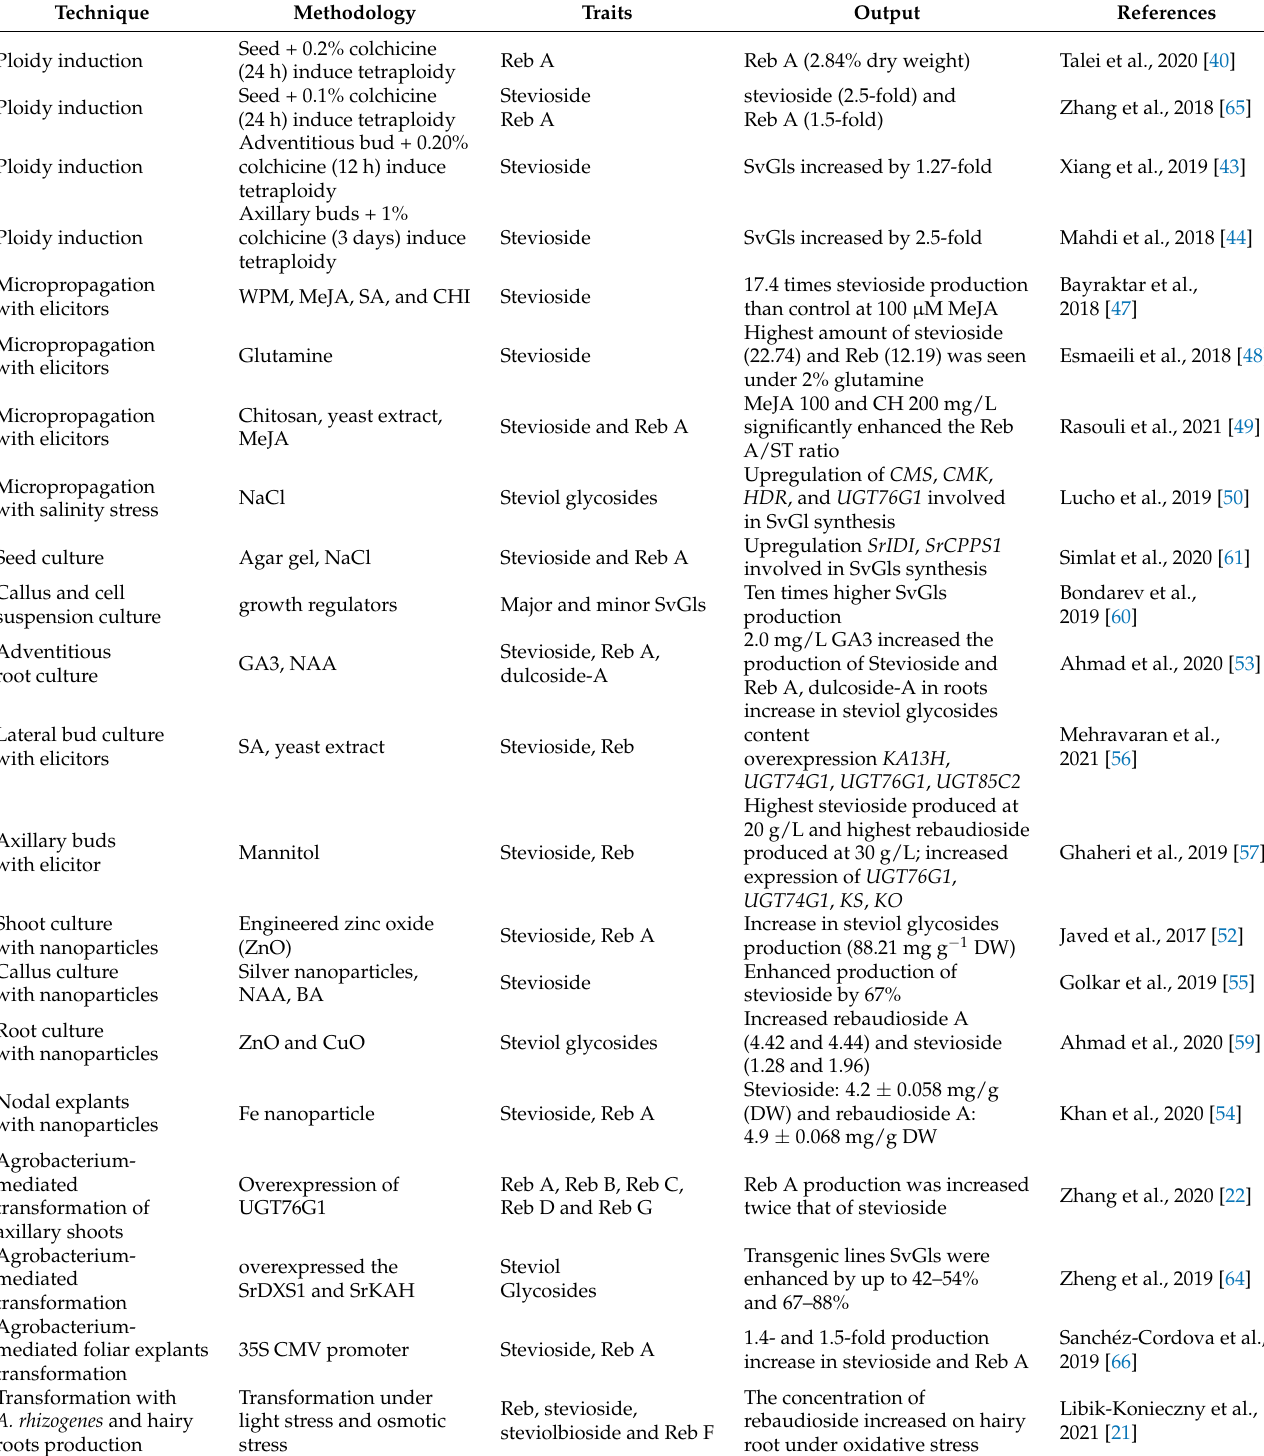
Table 2. Overview of the biotechnological strategies used to enhance SvGls production in S. rebaudiana